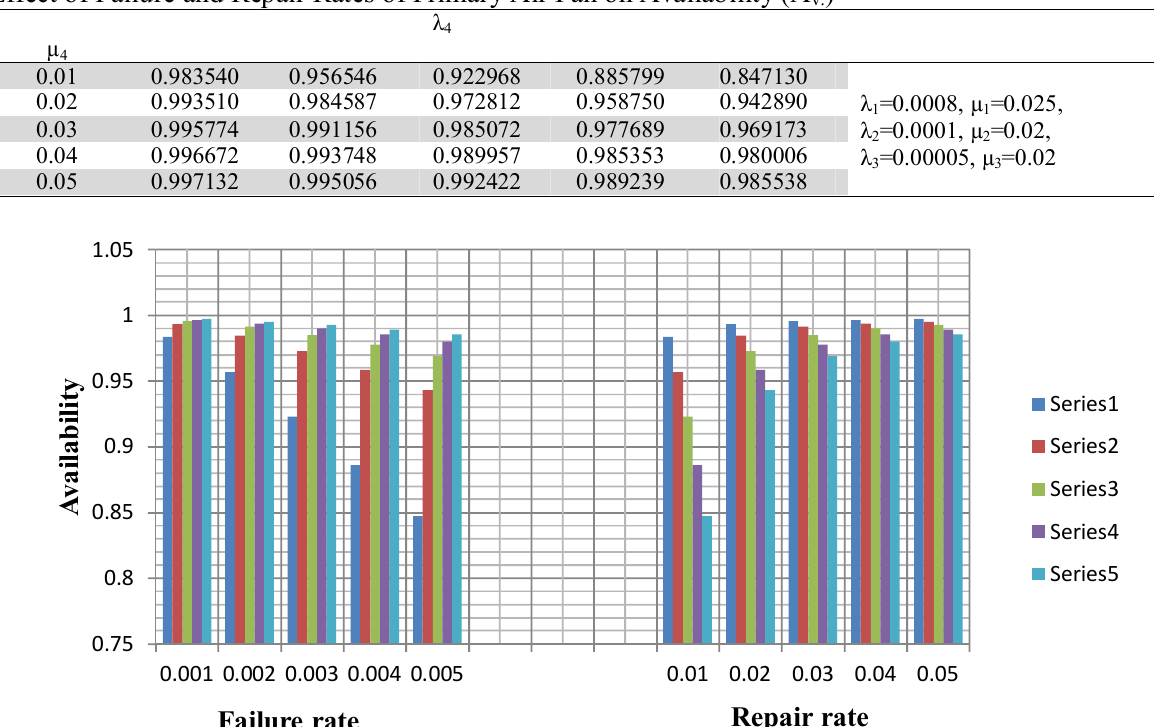
Fig. 5. Effect of Failure and Repair Rates of Primary Air Fan on Availability (A